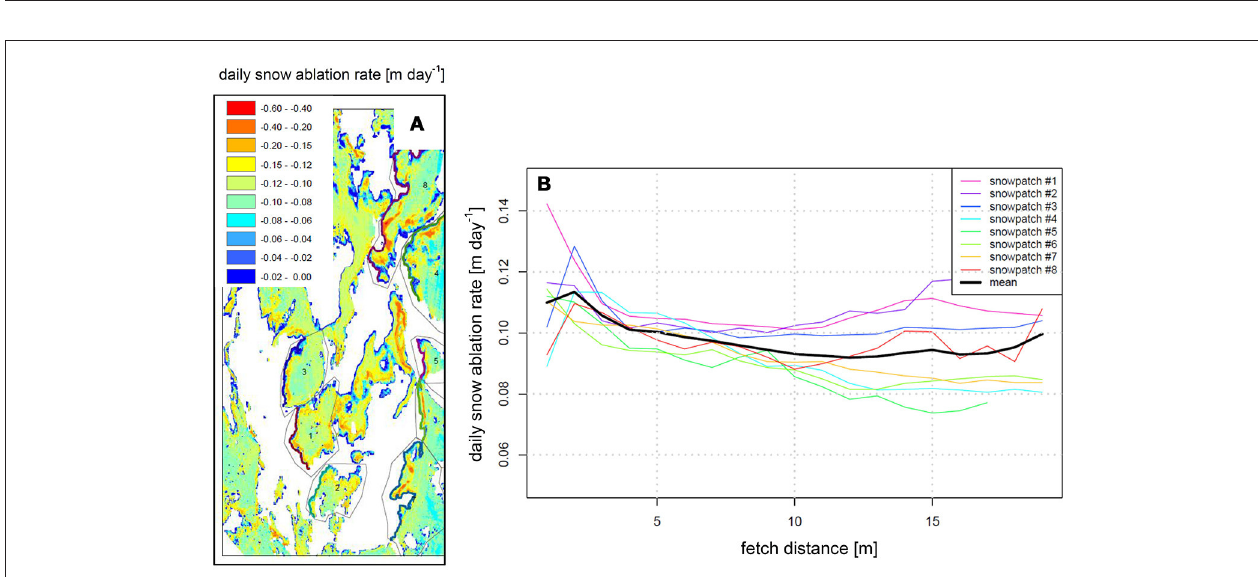
FIGURE 5 | Snow ablation rates [m day − 1 ] for 21 May 2014 at the Gletschboden test site. The dashed box in Figure 4A shows the location of the investigated area. (A) . Eight different snow patches were analyzed to assess the daily snow ablation as a function of the fetch distance (B) .